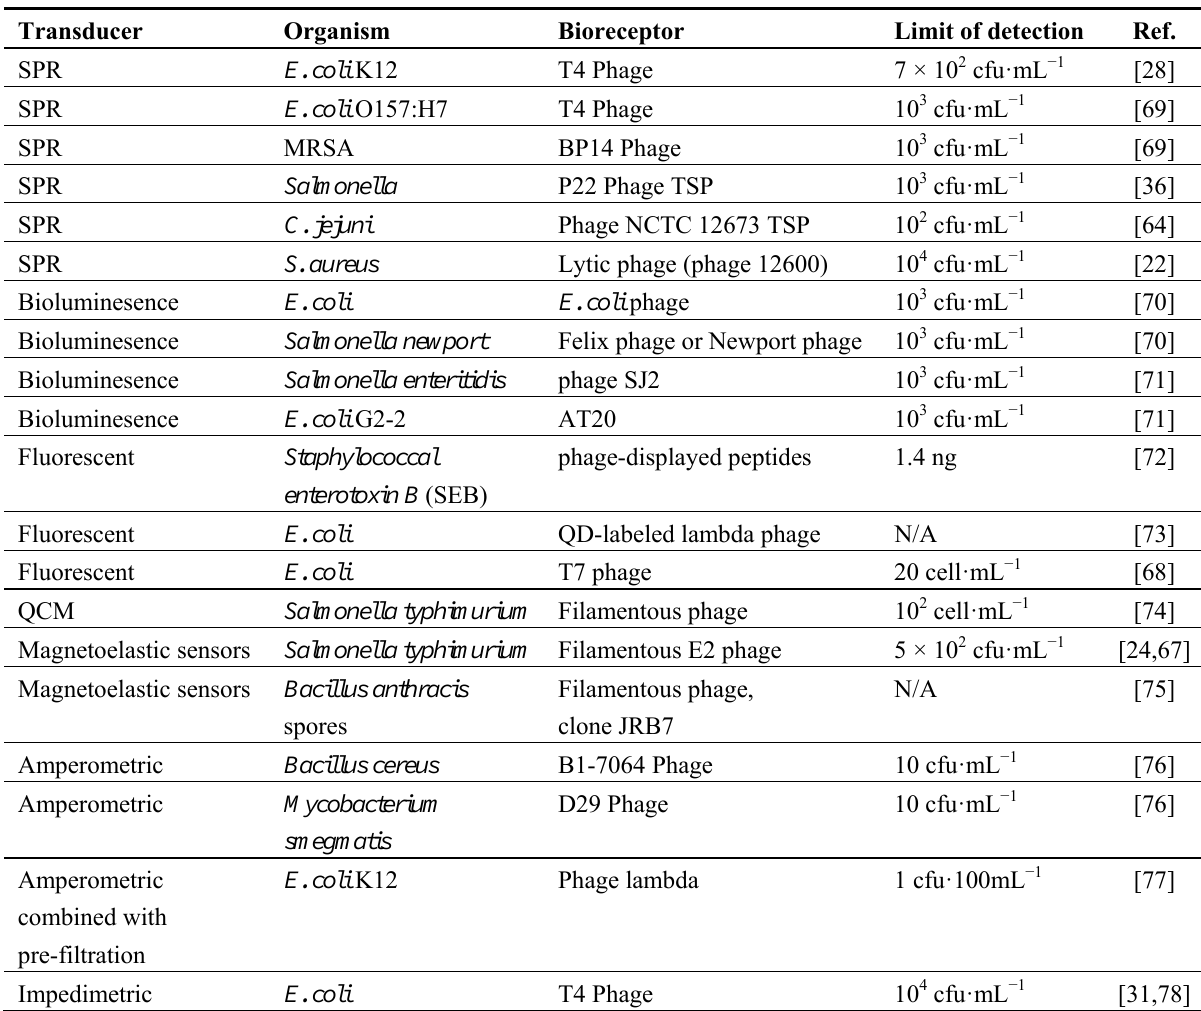
Table 3. A list of phage-based molecular probes exploited for pathogen detection highlighting the transduction platform used and limit of detection